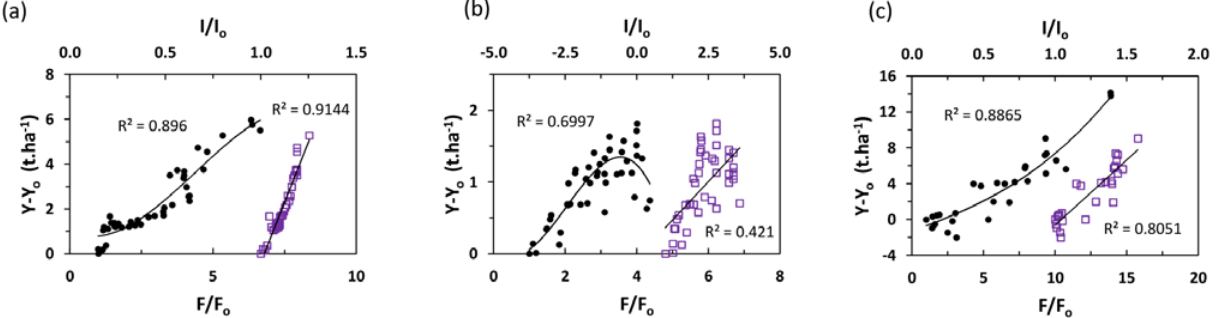
Figure 3. Variation of crop yield changes ( y − y ) as a function of total fertilizers o ; filled circles—primary x -axis (bottom)), and as a function consumption changes ( F/F o of irrigation changes ( I/I , open squares—secondary x -axis (top)), for maize-Egypt ( a ), o wheat-Greece ( b ) and potato-Morocco ( c ). The coefficient of determination (R 2 ) of the relationships between crop yield and each of the two variables is also shown. All the relationships are statistically significant at the 95% level ( p < 0.05). The subscript “o” denotes initial values ( i.e ., values at year 1961); while for the sake of a better visualization, = f( F/F ) and y − y = f( I/I ) are illustrated instead of y = f( F ) and y = f( I ), y − y o o o o respectively. The relationships y − y = f( F/F ) and y = f( F ), and y − y = f( I/I ) and y = f( I ) o o o o are indeed strictly